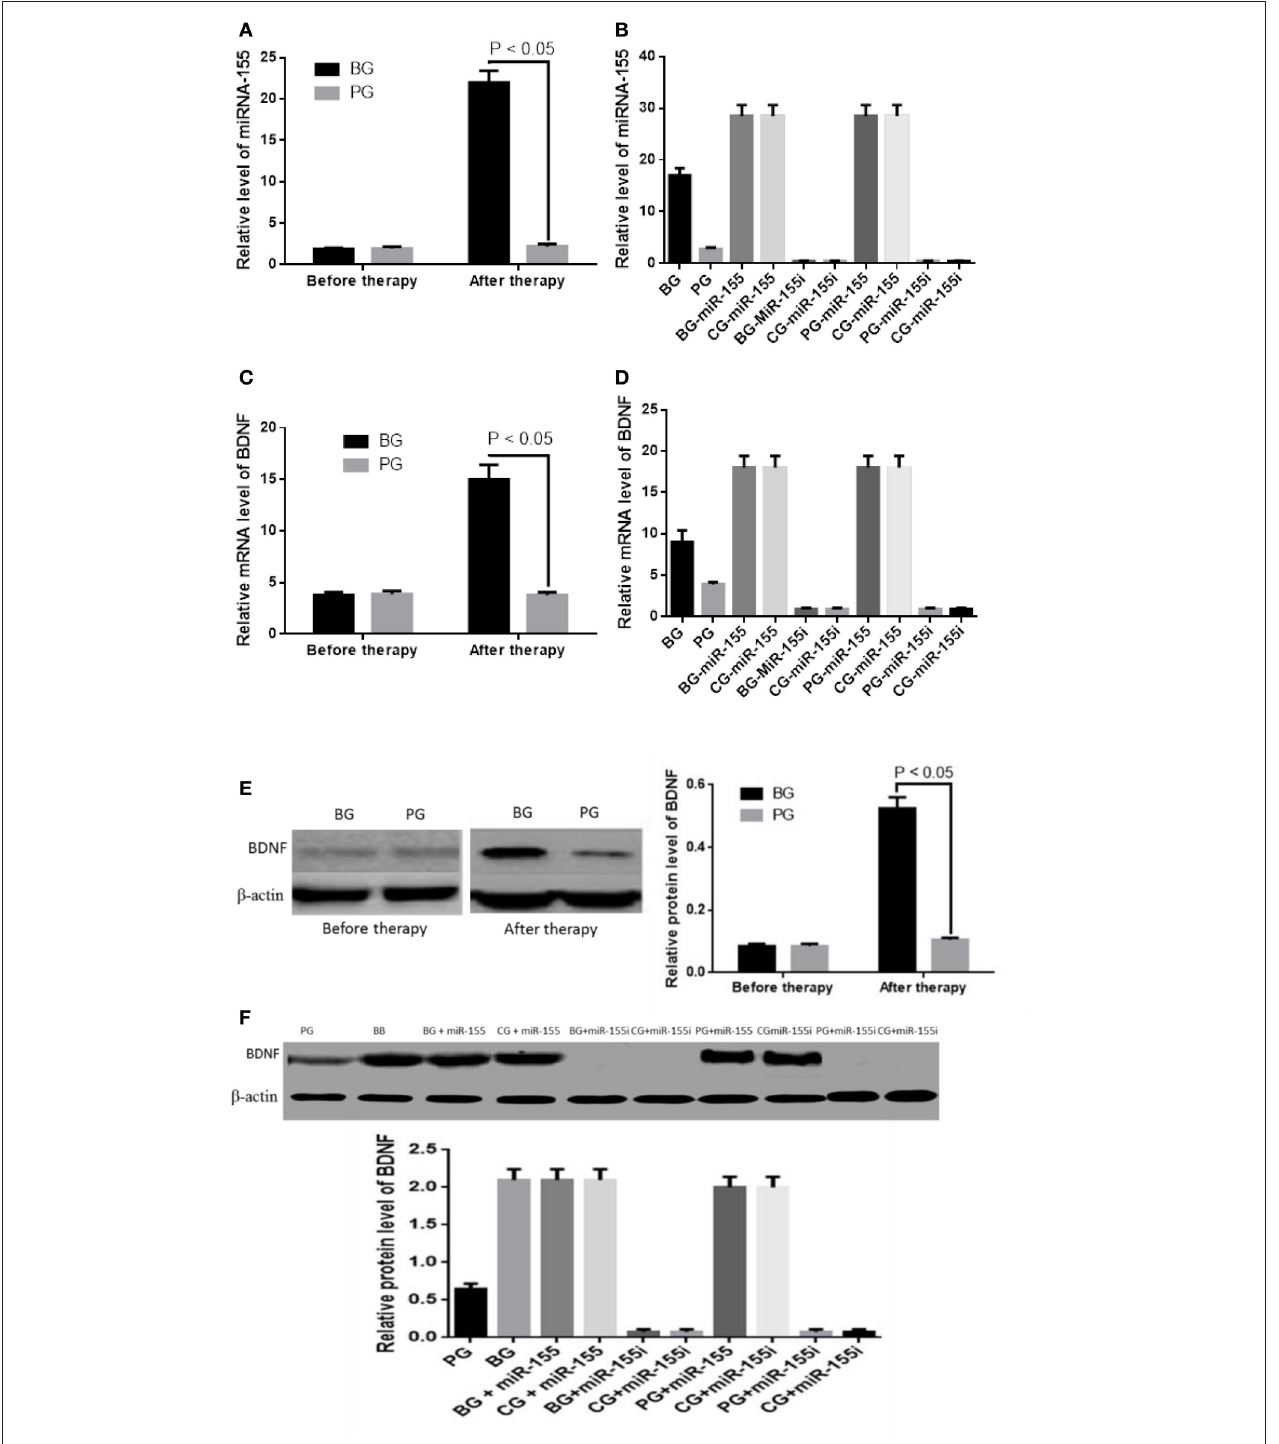
FIGURE 5 | Blueberry increases BDNF level via miR-155. (A) Real-time qRT-PCR analysis showed the serummiR-155 levels in BG and PG groups. (B) Real-time qRT-PCR analysis showed the serum miR-155 levels in HT22 hippocampus cells. (C) Real-time qRT-PCR analysis showed relative mRNA levels of BDNF in BG and PG groups. (D) Real-time qRT-PCR analysis showed relative mRNA levels of BDNF in HT22 hippocampal cells. (E) Western Blot analysis showed the BDNF protein levels in BG and PG groups. (F) Western Blot analysis showed the effects of miR-155 levels on BDNF protein levels.